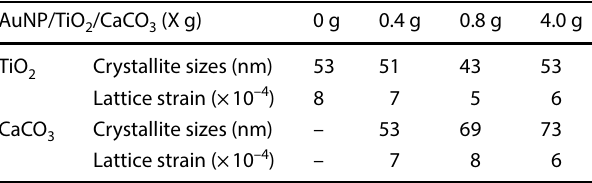
Table 1 Crystallite sizes and lattice strain estimated by Williamson– Hall plot of catalysts AuNP/TiO